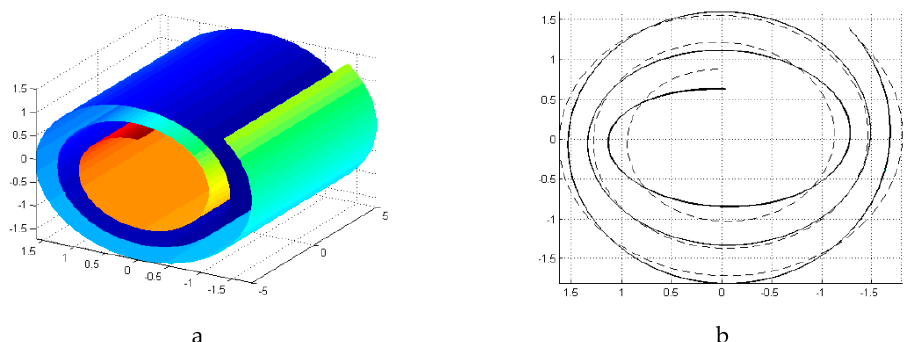
Figure 3. ( a ) Breathing like mode shape of the CNS; ( b ) the deformed cross section of CNS.